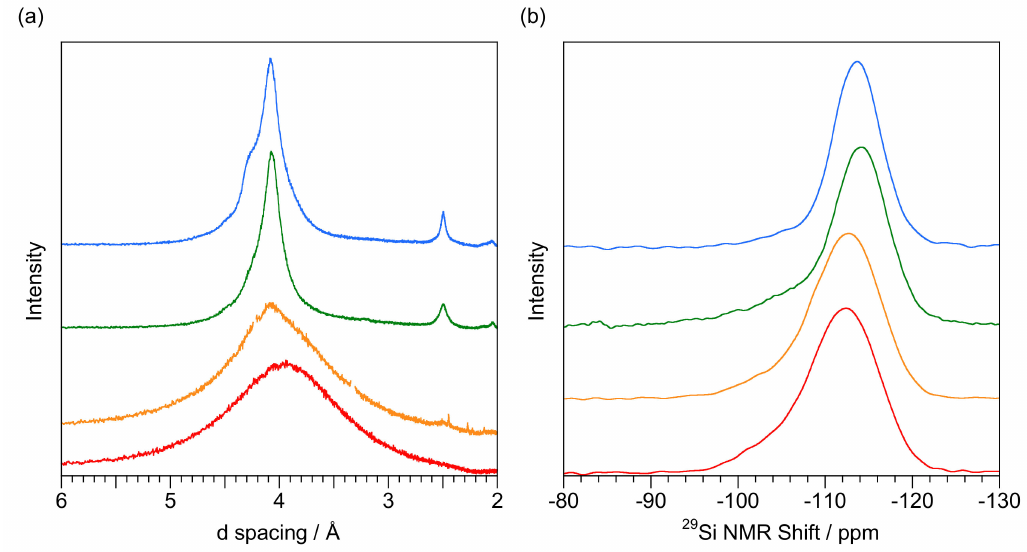
Figure 7. Comparison of opals at the presumed AG to CT boundary ( a ) XRD patterns ( b ) 400 s delay time 29 Si SP NMR spectrum for G1401 (opal-AG from White Cliffs NSW, with POC, red), G14581 (opal-AG to opal-CT transitional form from Andamooka, South Australia, orange), NMNH Eth S2 (opal-CT from Mezezo, Ethiopia with POC, green), GNEW24 (opal-CT from Kutahuya, Turkey with no POC, blue). Units are Å (XRD) and ppm (NMR). Major quartz peaks have been deleted from the XRD pattern of